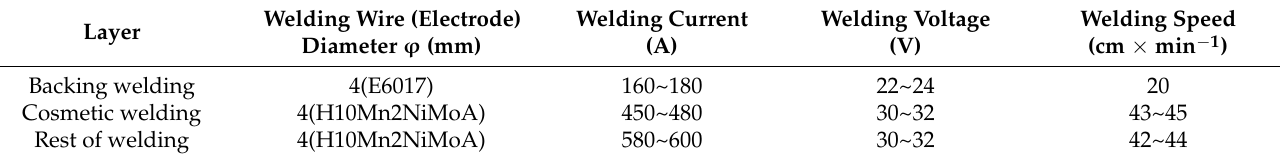
Table 4. The submerged-arc welding parameters of the